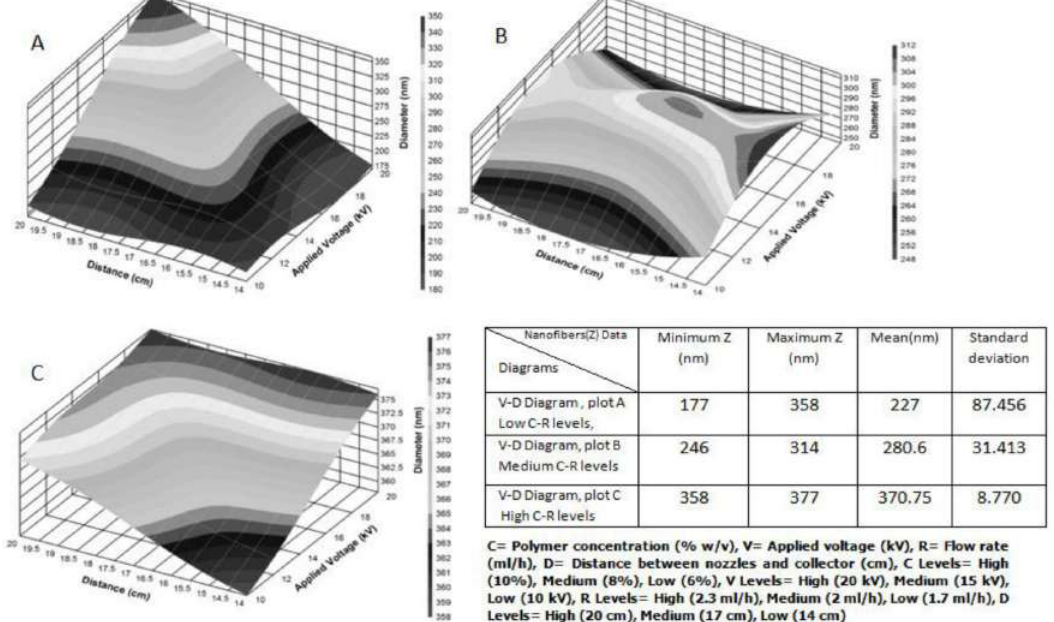
Fig. 7. The data and 3 D plots of nanofibers diameter predicted by ANN fixed in mentioned levels (V-D